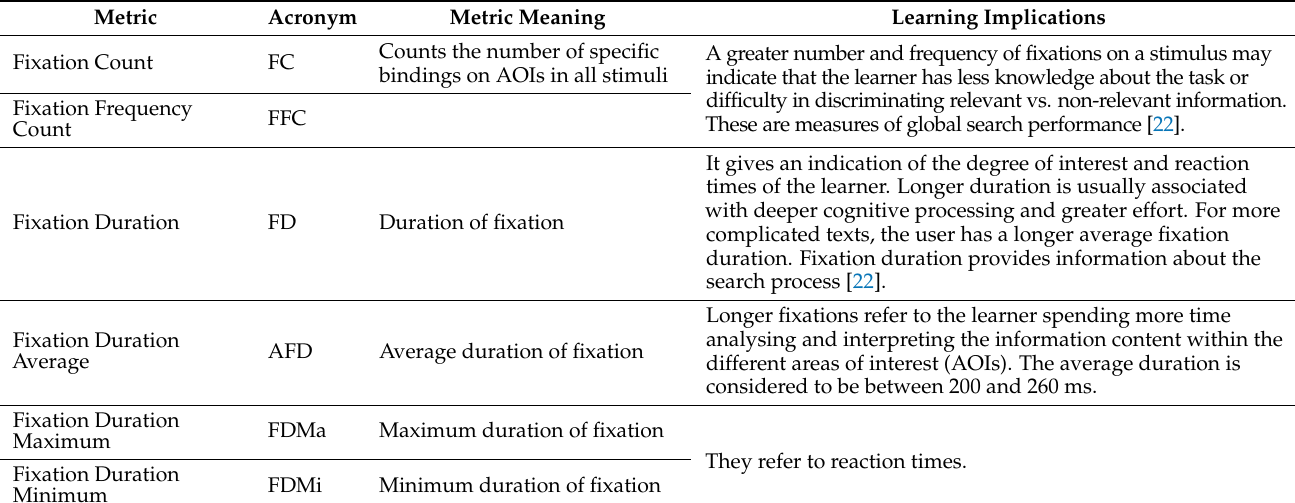
Table 1. Most representative parameters that can be obtained with the eye tracking technique and their significance in information